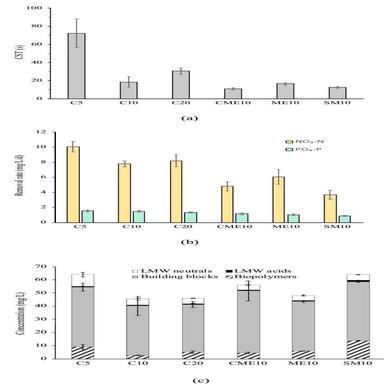
Average values of the (a) CST results, (b) NO3 −-N and PO4 −-P removal rates, and (c) concentrations of organic fractions for different cultures with controlled bacteria addition after Day 20 (n = 15), with error bars displaying the corresponding standard deviation.